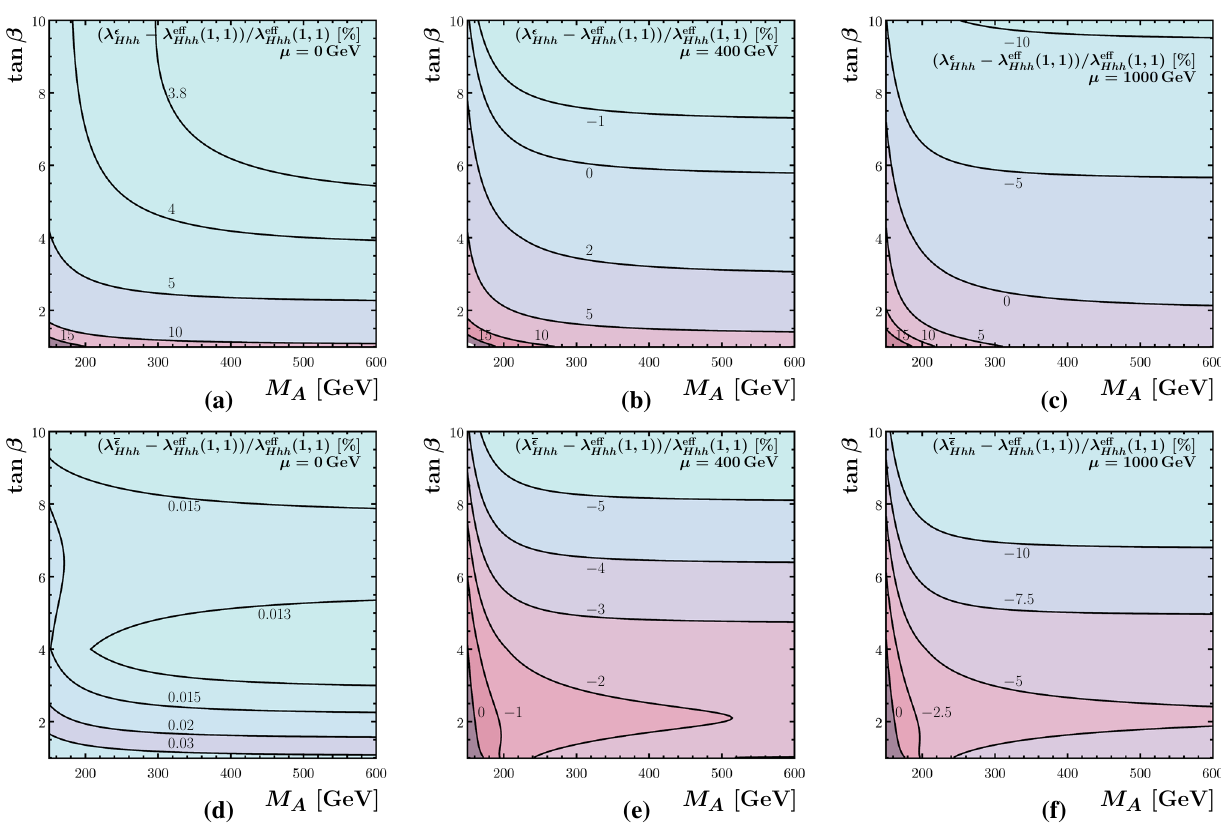
( 1 , 1 ) as a function of M Hhh